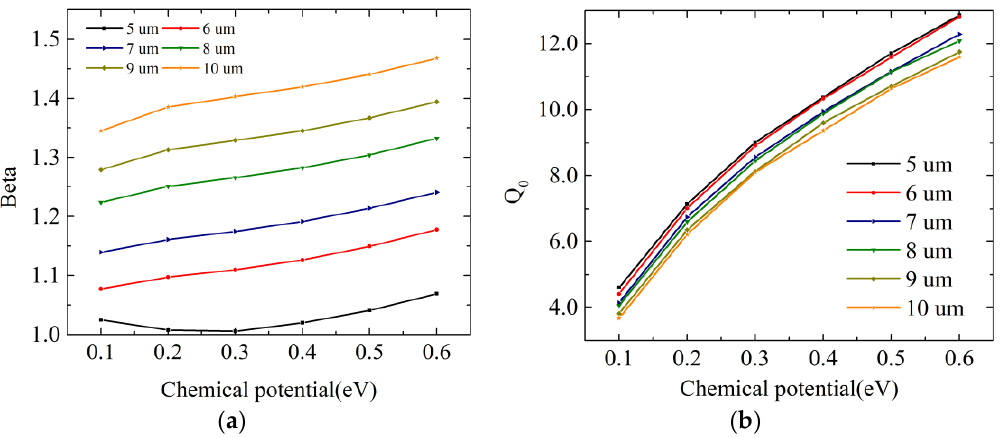
Figure 4. Calculated circuit parameter results versus chemical potential with arm length 5–10 µm. ( a ) β and ( b ) Q 0 curves with the arm length ranging from 5 µm to 10 µm over different chemical potentials.